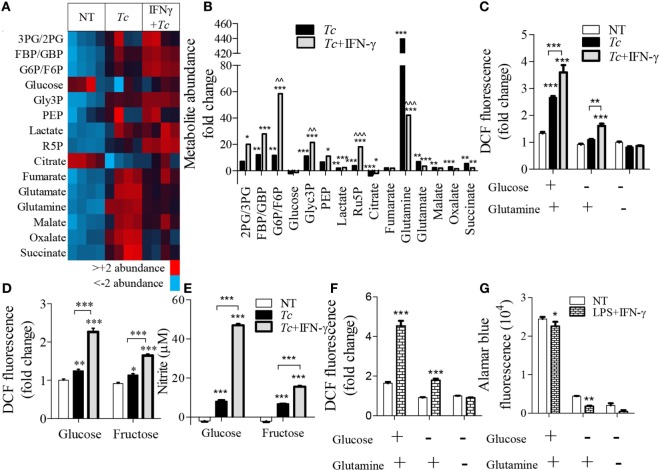
Relevance of glycolysis and pentose phosphate shunt in macrophage activation by Trypanosoma cruzi (Tc). RAW 264.7 macrophages were incubated for 18 h with Tc in presence or absence of IFN-γ (A–E) or with lipopolysaccharide (LPS) + IFN-γ (F,G). (A,B) Targeted profiling of the glycolysis and Krebs cycle metabolites was performed by LC-MS, and data are presented as heat map (A) and fold change compared to no-treatment controls with false discovery rate of 0.25 (B). (C–E) Macrophages were incubated for 18 h with Tc ± IFN-γ in the absence or presence of glucose, glutamine, or fructose. The intracellular reactive oxygen species (ROS) (C,D) and nitrite release (E) were measured by DCF fluorescence and Griess assay, respectively. (F,G) Macrophages were incubated for 18 h with LPS + IFN-γ in the presence or absence of glucose and glutamine. ROS (F) was determined by DCF fluorescence and cell viability (G) was analyzed by Alamar blue fluorescence. Data are shown as the mean of ≥3 biological replicates ± SEM. ANOVAB–H for metabolite analyses and ANOVABF for ROS and nitric oxide (NO) levels were used, where *p < 0.05, **p < 0.01, and ***p < 0.001 are compared to no-treatment controls, ^^p < 0.01 compared to the Tc-treated group, otherwise indicated by a line over compared groups. Abbreviations: 3PG/2PG, 3-phosphogluconate/2-phosphogluconate; GBP/FBP, glucose 1,6-bisphosphate/fructose 1,6-bisphosphate; Glyc3P, glycerol 3-phosphate; PEP, phosphoenolpyruvate; Ru5P, ribulose 5-phosphate.